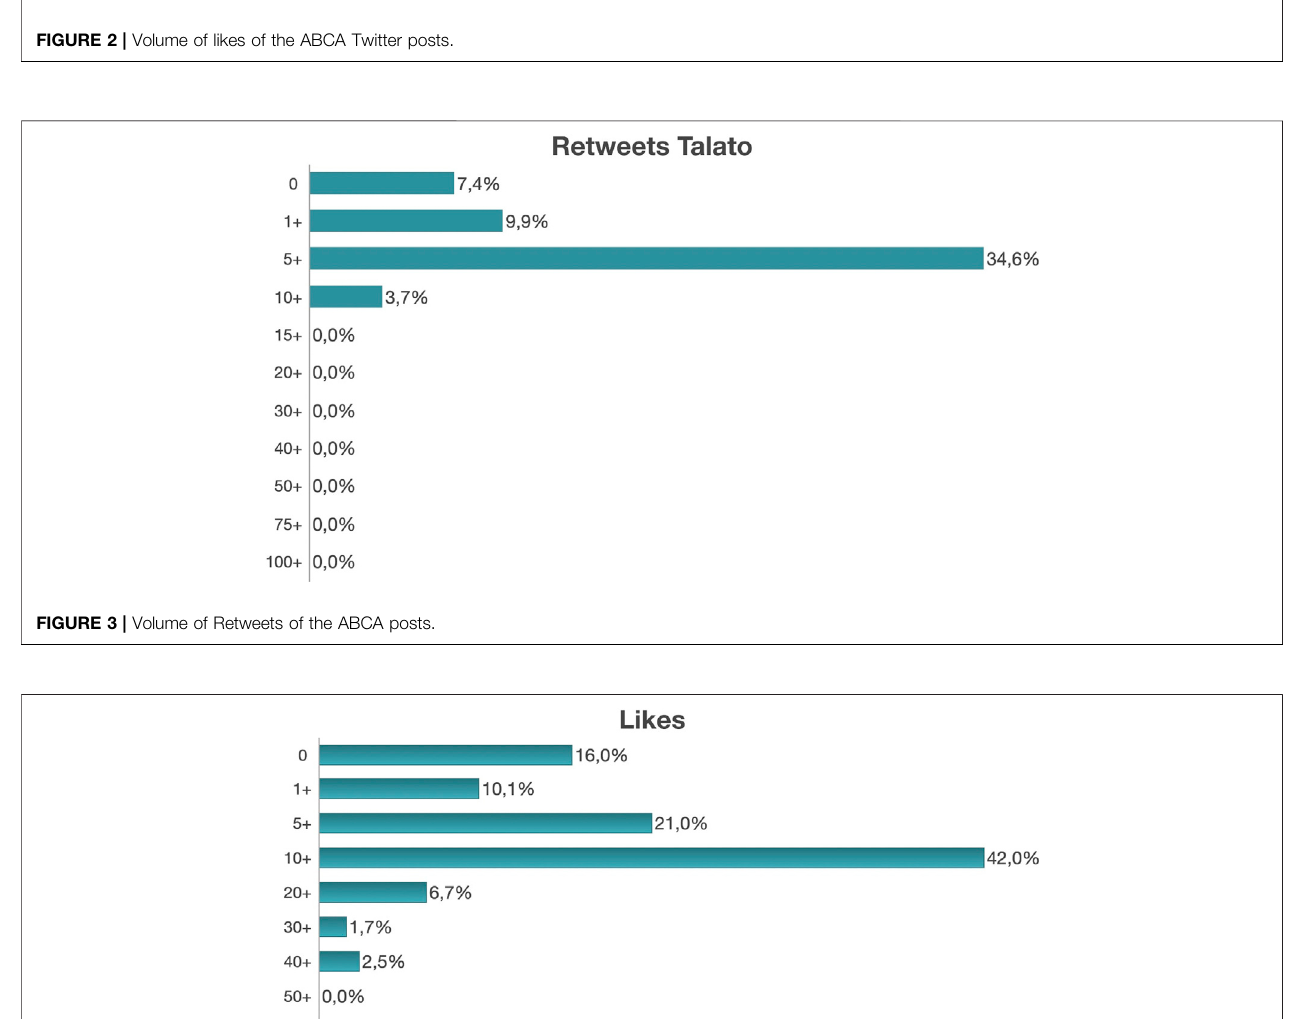
Frontiers in Communication |